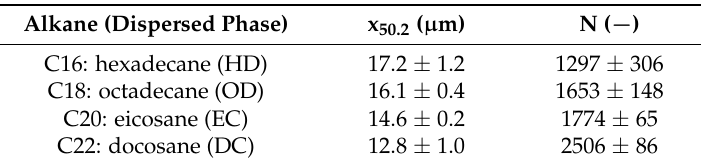
Table A1. Mean droplet diameter x 50.2 and number of characterized droplets N with standard deviations. Measured with polarizing light microscopy/image processing.